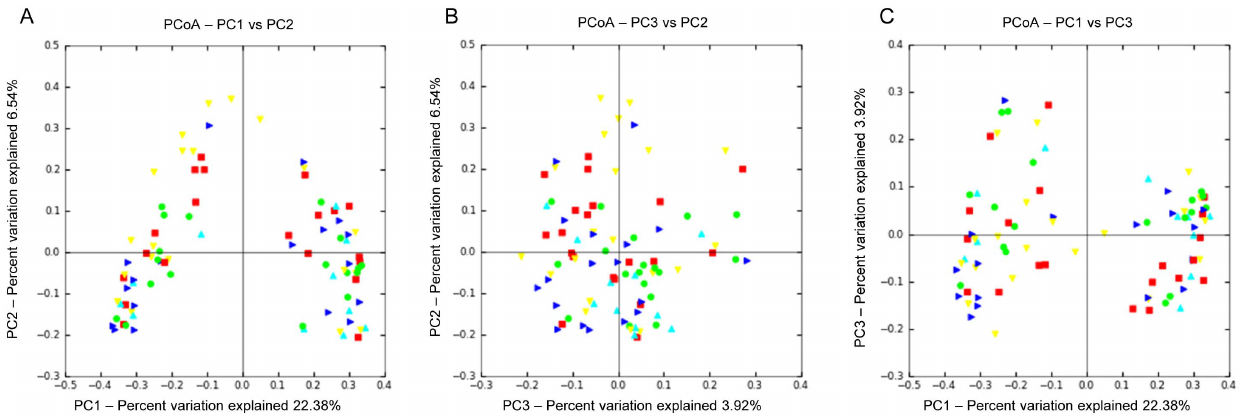
Figure 3. Principal coordinates analysis (PCoA) of unweighted UniFrac distances of 16 S rRNA genes. Analysis for 42 foals in groups control with CTB (red square), control without CTB (yellow triangle), low-dose inactivated R. equi (dark blue triangle), high-dose inactivated R. equi 2 (green dot), and live R. equi (light blue triangle) at 2 and 30 days of age (ANOSIM, P=0.236). The 3 panels represent the comparison of the first 2 principal components (A), the second and third principal components (B), and the first and third principal components (C). The pattern in the panel A is attributable to effects of age (please see Figures 4 and 5).